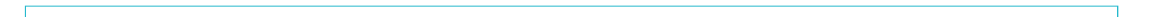
Figure 2: Illustration of goal-directed actions and habitual responses. (A) The “stimulus – action/ response – outcome” sequence. A per- son sees a bar (stimulus or environmental cue), enters the bar and orders a glass of wine (action/response, also referred to as the reward- seeking behaviour), and drinks the glass of wine (outcome, also referred to as the reward). Ordering a glass of wine can be either a goal-di- rected action or a habitual response. (B) The goal-directed action is driven by the representation of the outcome (the glass of wine) and is performed in order to obtain this outcome. Therefore, if the outcome (the glass of wine) becomes less valuable (e.g., after intoxication) the ac- tion will less likely be performed by the goal-directed mechanisms anymore. (C) On the other hand, habits are solely triggered by antecedent stimuli (the sight of the bar sign) without the representation of the outcome (the glass of wine) being involved in the process. Therefore, the re- sponse (entering the bar and ordering a glass of wine) will be performed upon the perception of the bar sign, even if the future outcome (the glass of wine) has been devalued (e.g., after